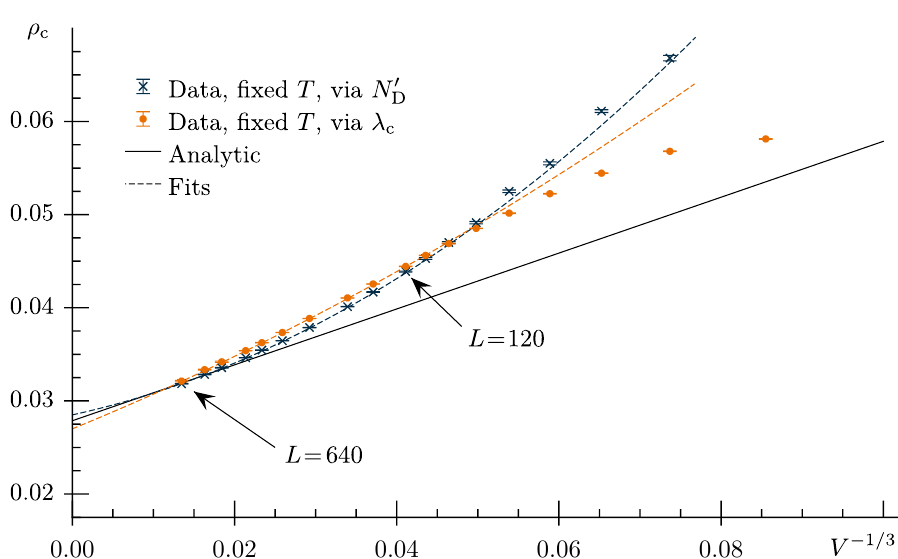
( V ) at T = 0.4. Two dif- Figure 8: Finite-size scaling of the transition density ρ c ferent criteria were employed to pinpoint the transition: For the blue crosses, the peak position of N (cid:48) was used, while the yellow circles stem from the density at D which the droplet size crosses the threshold of λ = λ . The slope and offset of the c − 1 / 3 ) were determined from grand canoni- ( V ) = ρ + a analytic prediction ( ρ ρ V c g cal observables. The arrows indicate the range of data points used for the two fits − 1 / 3 + ˜ b − 2 / 3 ( V ) = ˜ ρ + ˜ a ( ρ ρ V ρ V c g